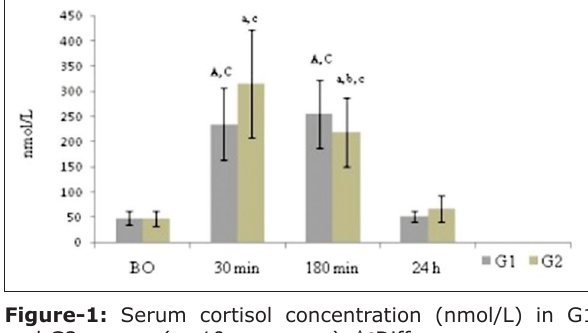
Figure-1: Serum cortisol concentration (nmol/L) in G1 and G2 groups (n=10 per group). A,a Differences compared to BO; B,b Differences compared to 30 min; C,c Differences compared to 24 h; BO - Before the ovariohysterectomy. Capital letters indicate significant difference (p<0.01) between time points in G1. Small letters indicate significant difference (p<0.01) between time points in